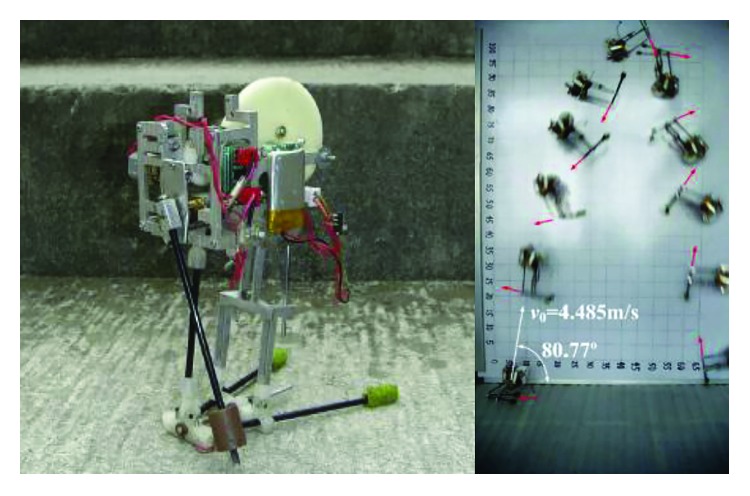
Micro jumping robot [45].